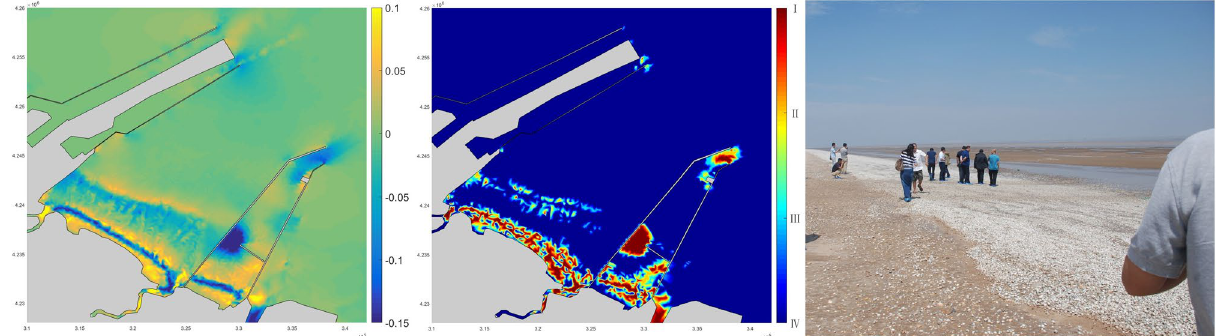
Figure 8. Storm Lekima: computed net seabed changes; damage state (I: highest, IV: lowest) assessment of the inhabiting clam with averaged size of 3.5 cm; post-storm “shell belt” of clams at the coastline (processed by Mike 21 at https ://www.mikep owere dbydh i.com/produ